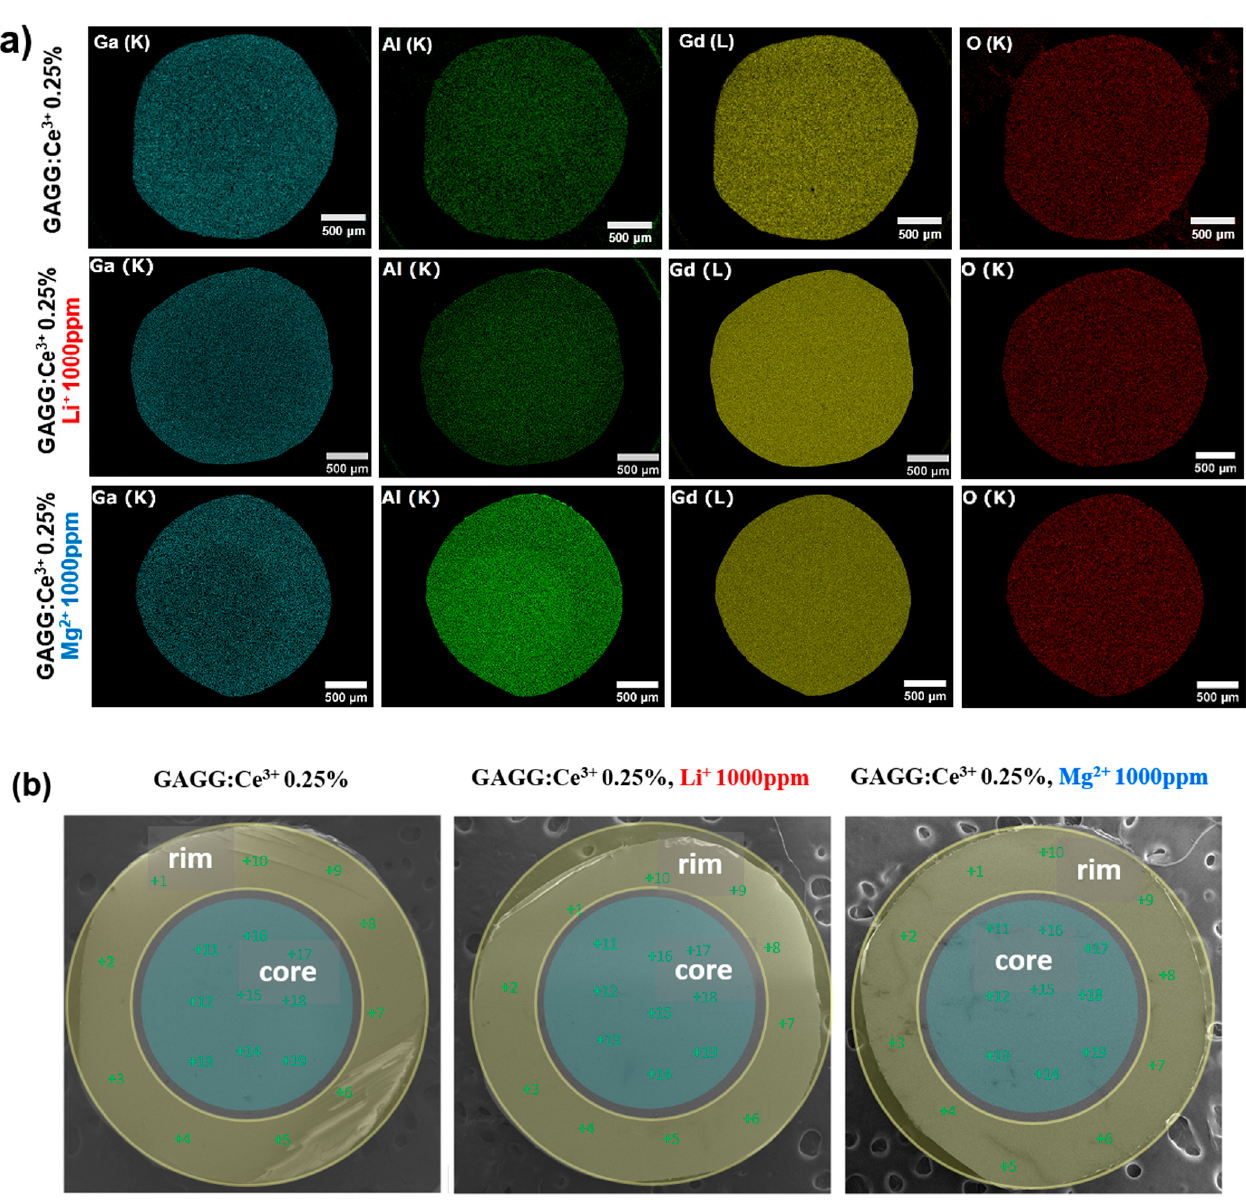
Figure 3. ( a ) Multielemental EDS mapping images for oxygen (O), gadollinium (Gd), aluminium (Al), and gallium (Ga) atoms, and ( b ) SEM images of radial plates along with marked spots of EDS elemental analysis in Li + and Mg 2+ co-doped GAGG:Ce crystals, 300 K. Green crosses with numbers represent the locations of the EDS composition measurements.